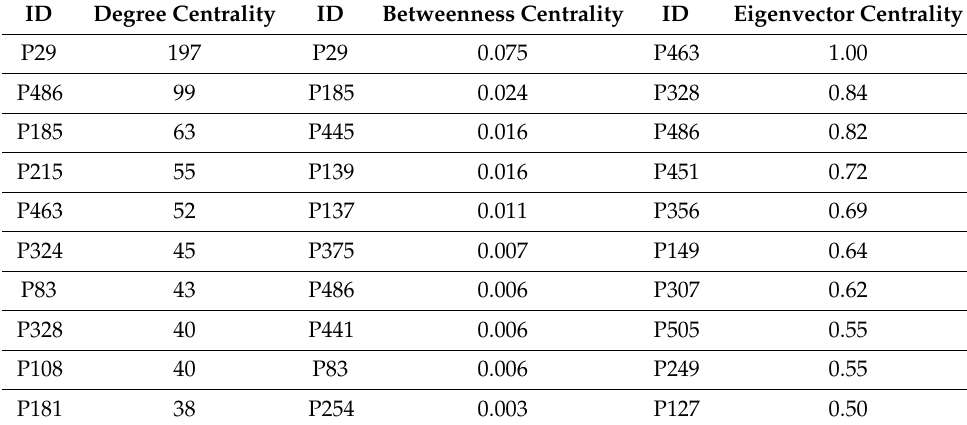
Table 17. Centrality measures of citation